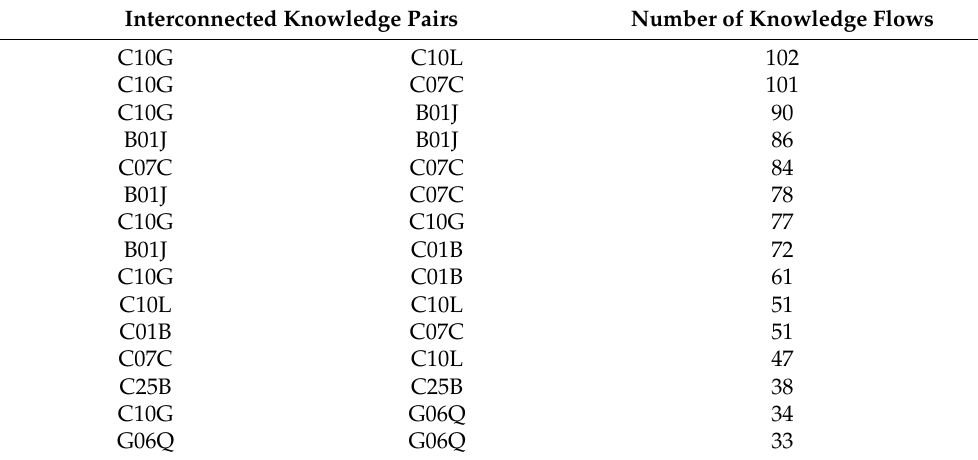
Table 2. Top 15 knowledge flows. (Note: The description of IPCs from Table 2 can be found in Appendix